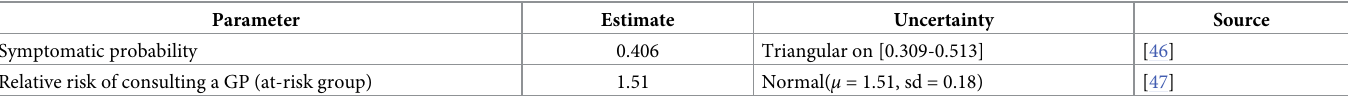
Table 3. Symptomatic case and GP consultation